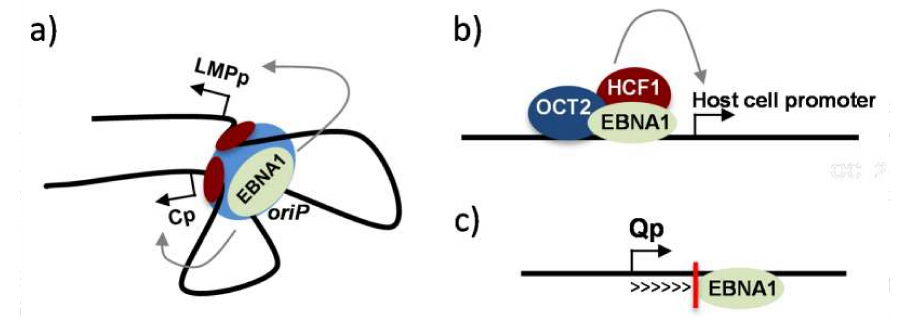
Figure 3. Representation of various mechanisms of gene expression regulated by EBNA1. ( a ) Model showing CCCTC-binding factor (CTCF)/cohesin-mediated DNA looping interactions between oriP and regions close to the Cp and latent membrane protein (LMP) promoters. Such loops bring FR-bound EBNA1 into close proximity with the Cp and LMP promoters, thereby allowing their transcriptional regulation. ( b ) Model of transcriptional regulation by EBNA1 bound onto consensus recognition sites present in the promoters of various cellular target genes. Cooperation with various cellular factors—here OCT2 and HCF1—is likely to be critical for EBNA1-mediated chromatin remodeling and transcriptional regulation outcome. ( c ) By binding to two sites placed in tandem position 10 bp downstream of the transcription start site (TSS) (indicated by the black arrow), EBNA1 represses its own expression from the Qp promoter by a mechanism that blocks processing of the primary